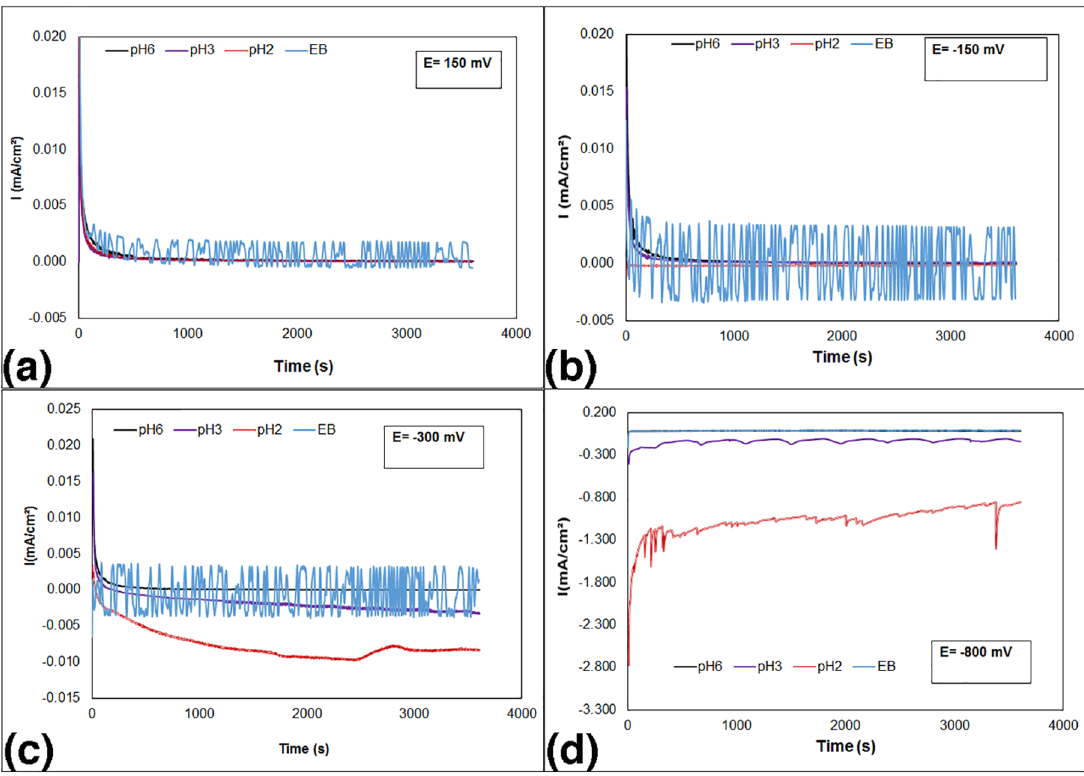
Figure 4. Chronoamperometry curves of Co-Cr-Mo alloy at different potential: (a) 150 mV; (b) -150 mV; (c) -300 mV; (d) -800 mV